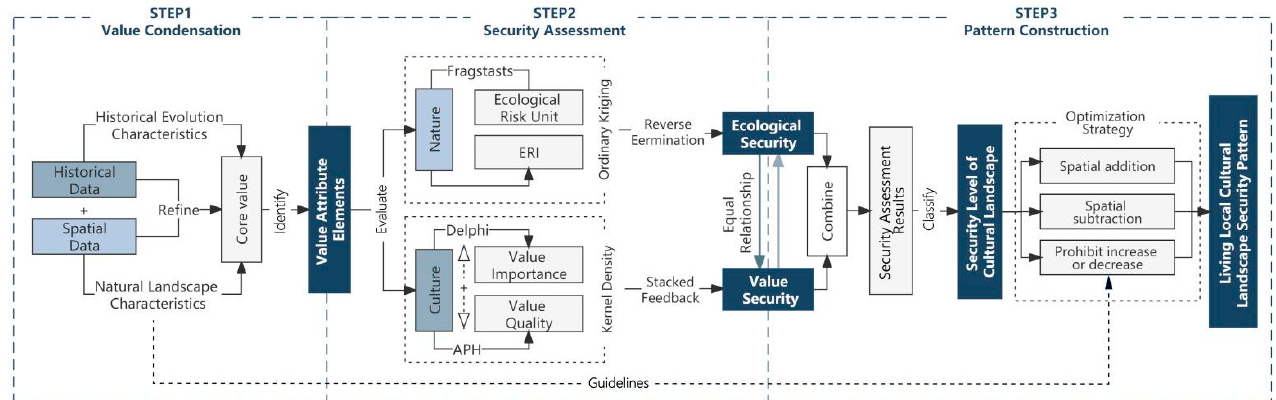
Figure 2. The framework of the transregional vernacular cultural landscape security pattern.